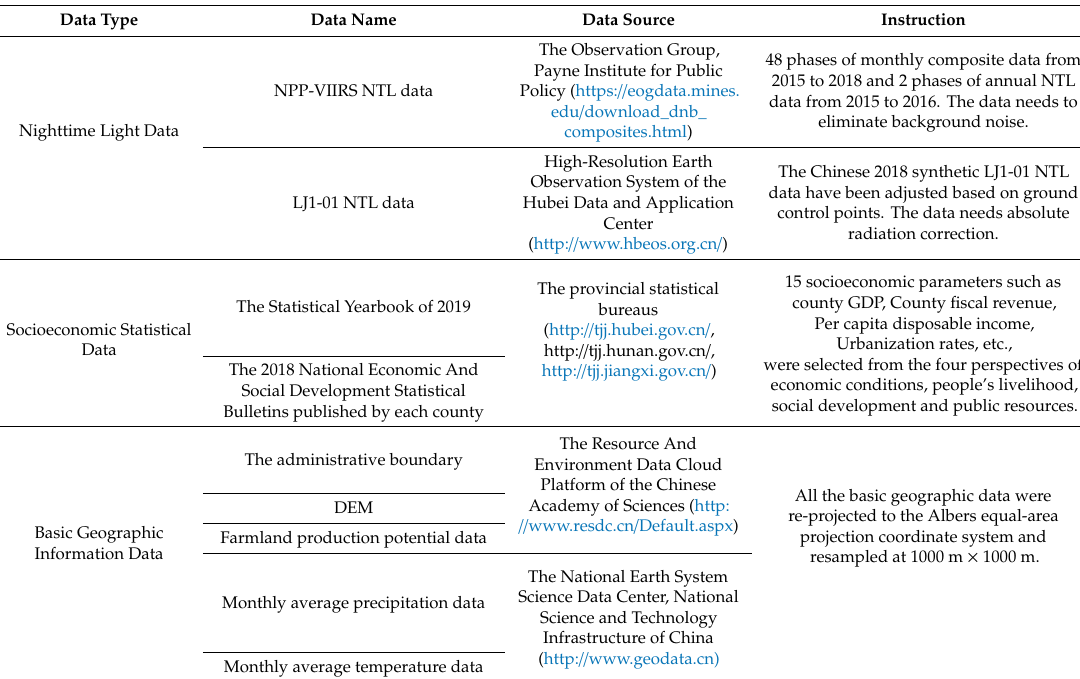
Table A2. Data sources used in this article and related